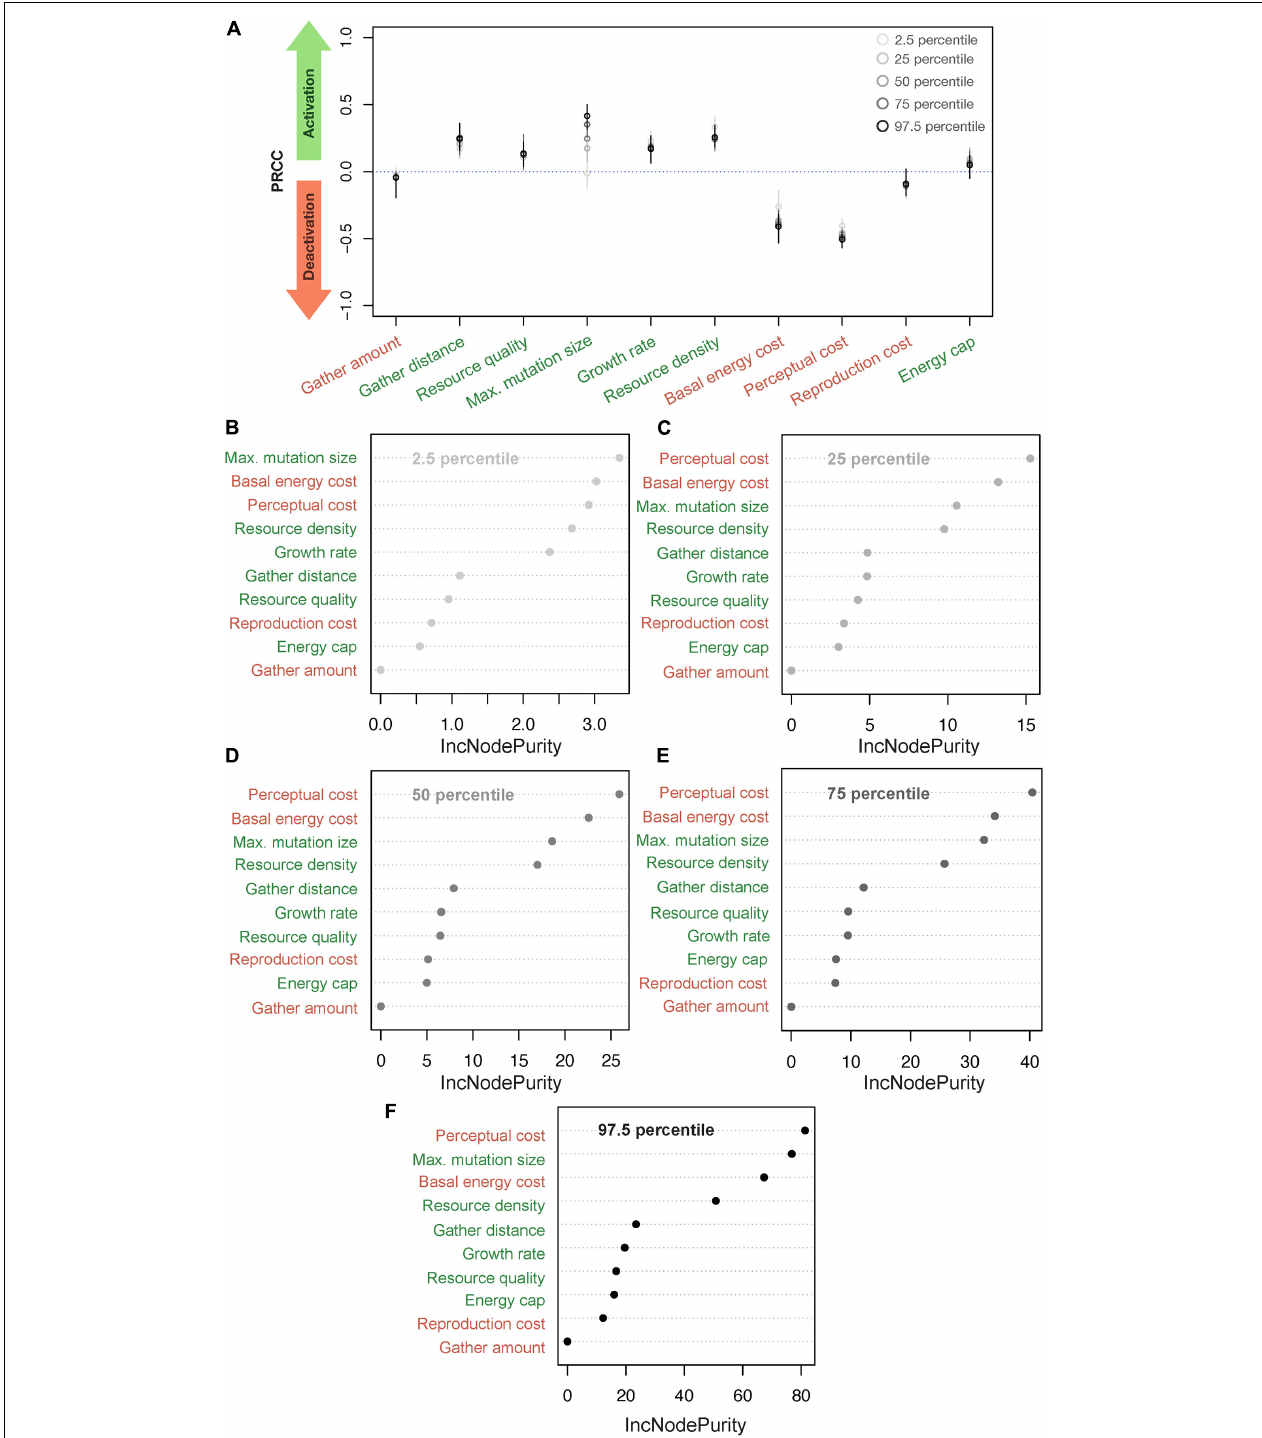
FIGURE 2 | Finding critical parameters. (A) Classifying parameters into activating and deactivating groups using partial rank correlation coefficient (PRCC); parameters where the mean PRCC is above 0.0 are activating and those with mean PRCC below 0.0 are termed deactivating. (B–F) Represent a Random Forest (RF) Regression of different parts of the resultant perceptual range distribution from the parameter values where (B–F) represent the results for 2.5, 25, 50, 75, and 97.5 percentiles, respectively (and percentage of variance explained: 74.84, 70.03, 70.25, 70.16 and 72.92%, respectively). The labels in green are activating parameters and those in red are deactivating. The x -axis in (B–F) , IncNodePurity, refers to the total decrease in node impurities from splitting on a given parameter, averaged over all trees. Higher IncNodePurity means higher variable importance.